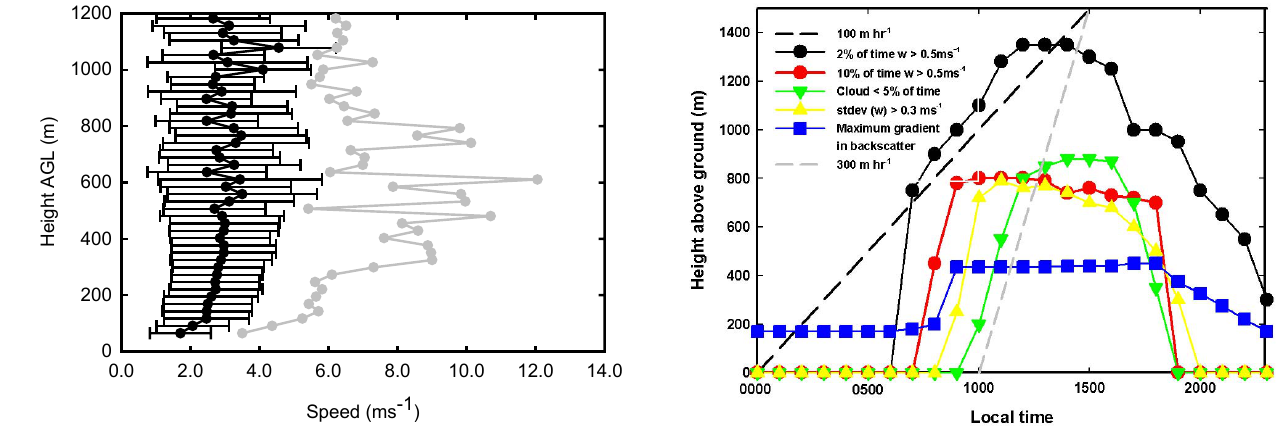
Fig. 10. A summary of the various modes of data analysis that have been used to paramaterise the structure of the tropical bound- ary layer. See discussion section for paramaterise the structure of the tropical boundary layer. See discussion section for details.